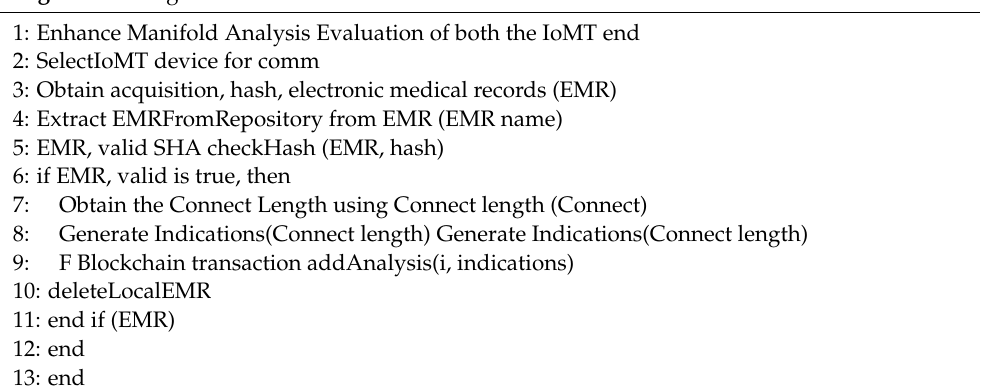
Algorithm 3 Algorithm Method